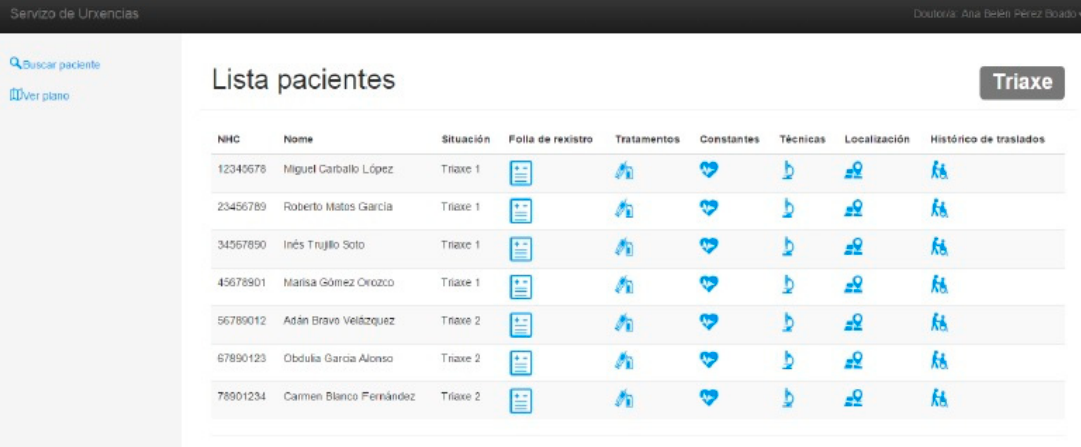
Figure 4. Patient list assigned to a doctor in different locations within the emergency services area.